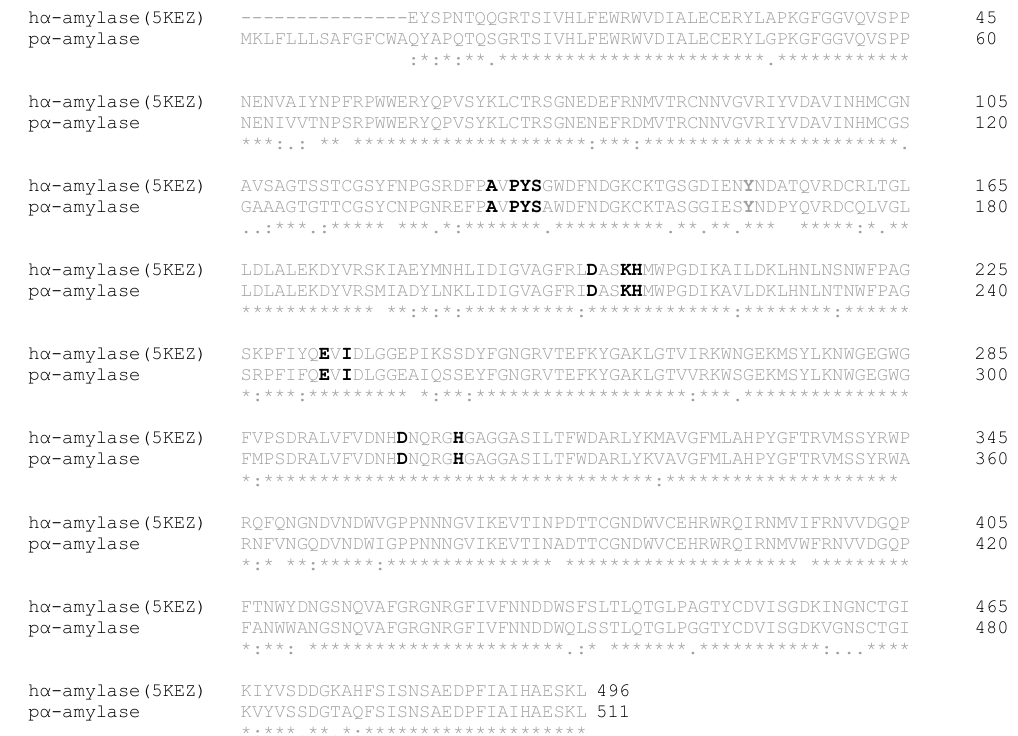
Figure 3. Sequence alignment between human pancreatic α‐ amylase (h α‐ amylase; 5KEZ) and porcine pancreatic α‐ amylase (p α‐ amylase) as generated with Clustal Omega (www.ebi.ac.uk/Tools/msa/clustalo/). Binding site residues selected for docking studies are bold typed. Symbols at the bottom indicate identity (*), high (:) or moderate (.) similarity.